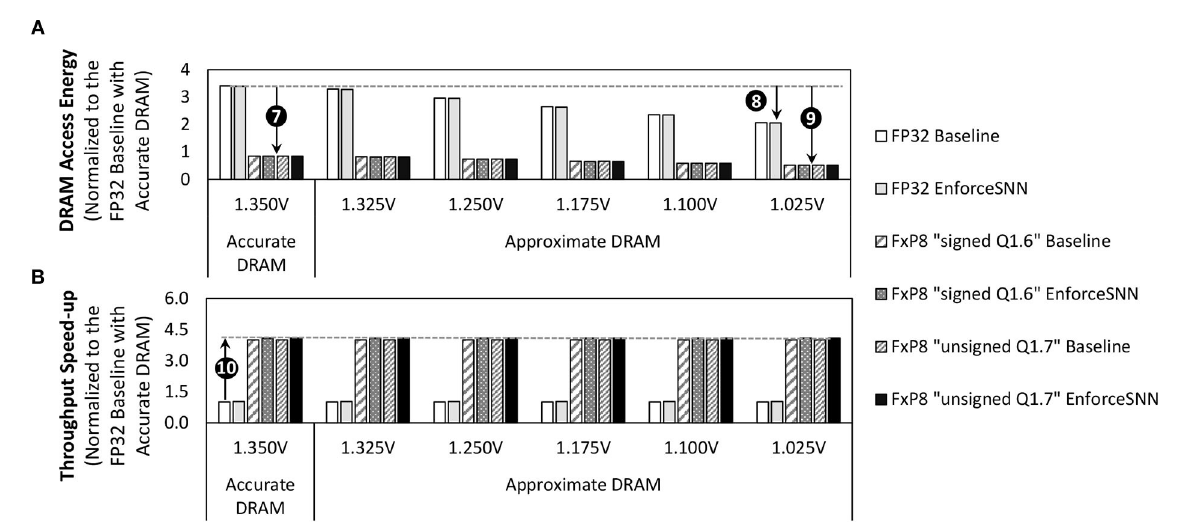
FIGURE12 (A) The normalized DRAM access energy for an inference incurred by the baseline model and the EnforceSNN-improved model with accurate and approximate DRAM, and (B) the normalized speed-up of DRAM data throughput for an inference achieved by our EnforceSNN-improved model over the baseline model, across different V supply values, different workloads (datasets), and different network sizes (N-900, N-1600, N-2500, and N-3600). These results are applicable for all network sizes. They are also applicable for both the MNIST and Fashion MNIST datasets, as these workloads have similar DRAM access energy, due to the same number of weights and number of DRAM accesses for an